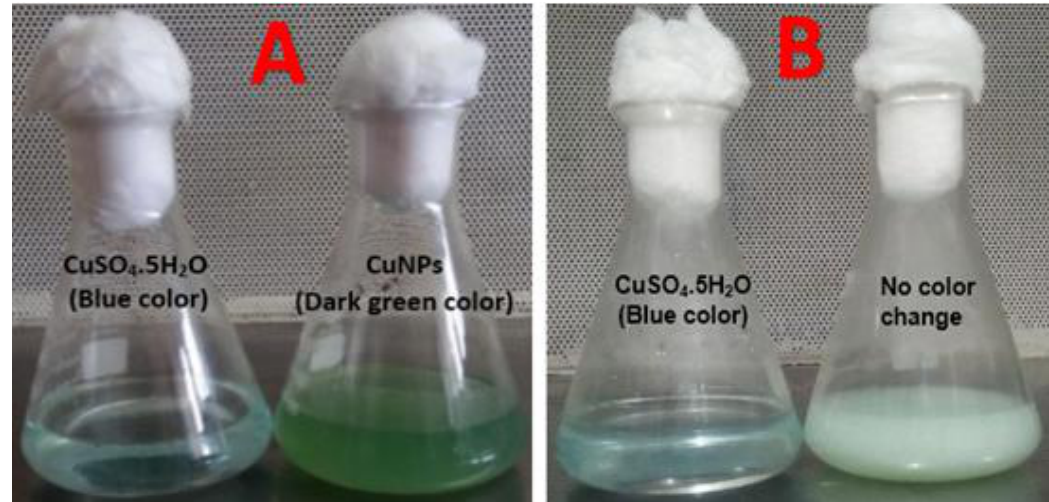
Figure 5. ( A ) Color change in the in the intensity of the reaction of CuNPs formation. ( B ) No color change occurs when 1 g of cell pellet is added to the CuSO 4 ·5H 2 O solution.